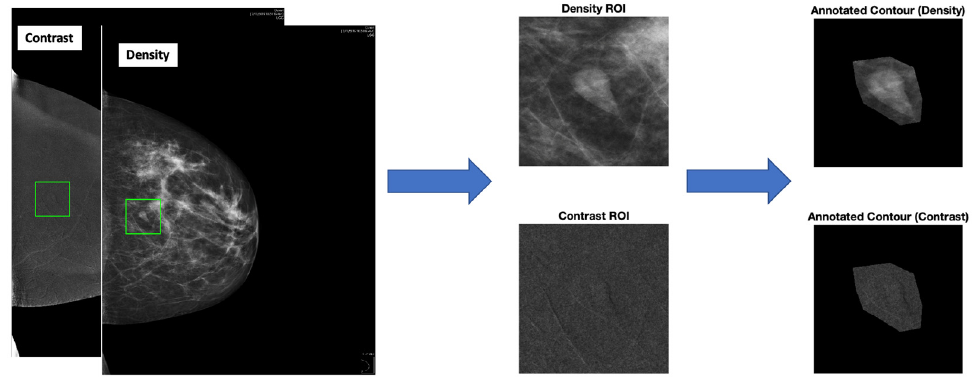
Figure 1. Process of image review and annotation. Each suspicious CEM lesion was annotated with a rectangular box ROI (green box) as well as a contoured, hand-drawn ROI in preparation for quantitative image analysis. The sizes of the mammogram images varied from patient to patient; however, the ROIs were chosen to be of a size 300 × 300 in pixels.